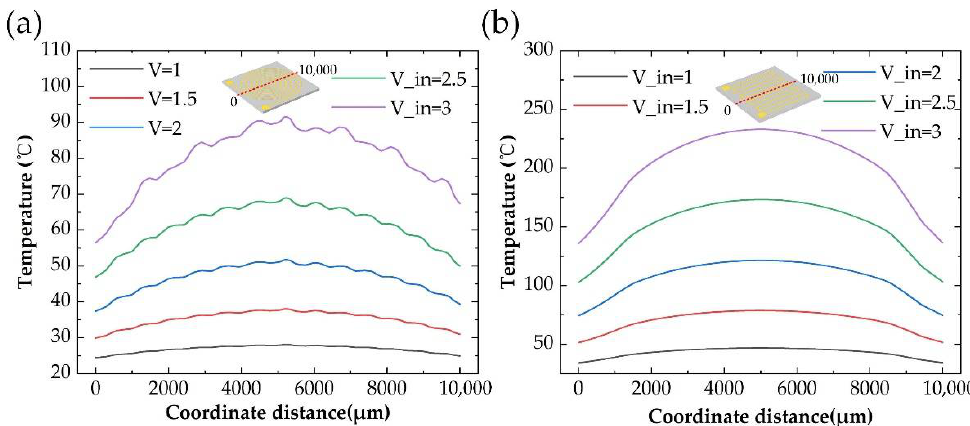
Figure 6. The surface temperature distribution along the center line for ( a ) the Circular-shaped struc- ture, and ( b ) the S-shaped structure with different input voltages, with structure indicated as in the inserted picture.